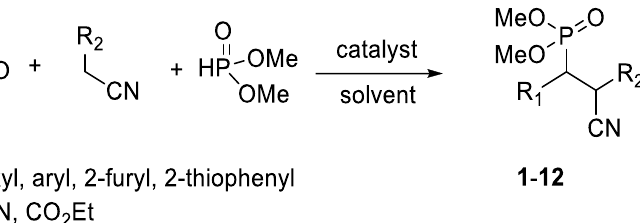
Figure 3. β -Phosphonomalononitriles 1 – 10 and β -phosphononitriles 11 and 12 obtained via an enzyme-catalyzed phospha–Michael addition. Yields in brackets provided for isolated products 1 – 14 .